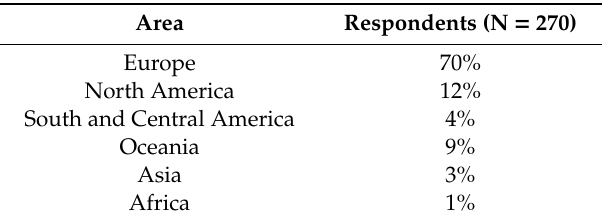
Table 2. Percentage (%) of respondents for each geographic area.